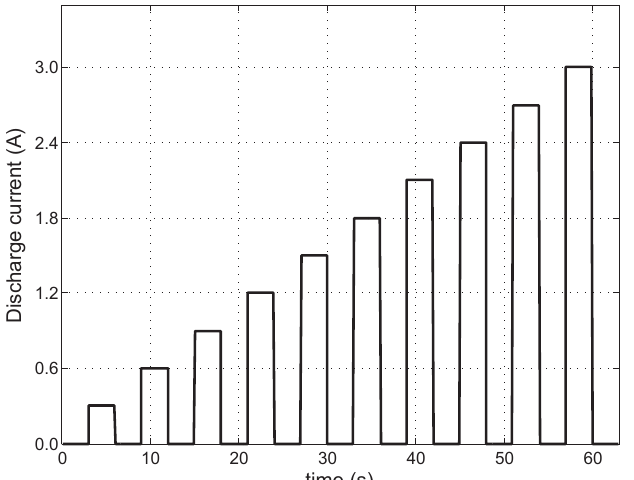
Figure 4. Pulse discharge current used to examine the variation in the internal